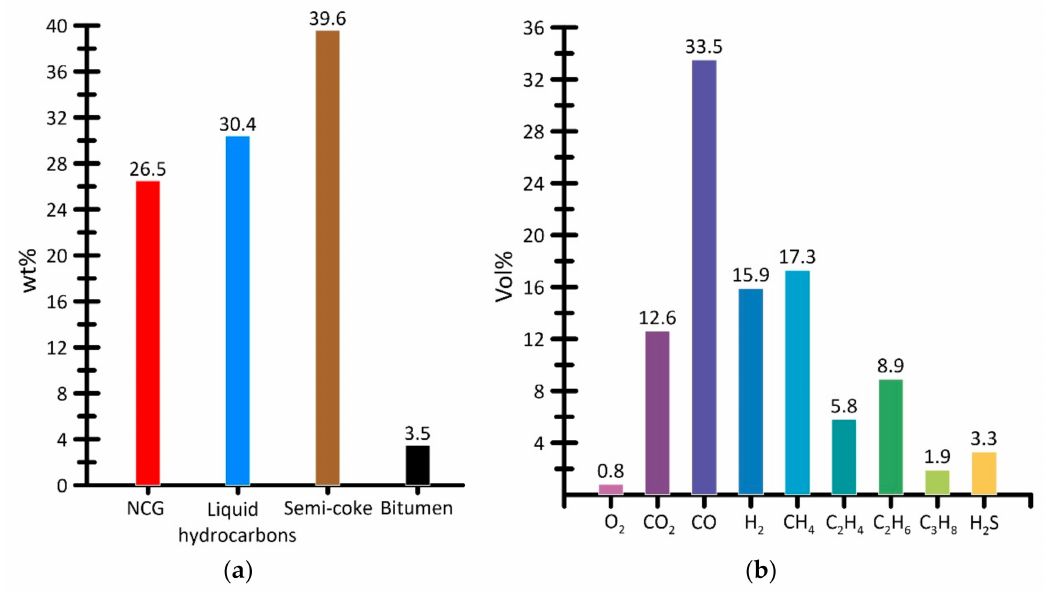
Figure 6. ( a ) Material balance of the products yielded by steam pyrolysis of OS and ( b ) the composi- tion of non-condensable gas-phase (NCG)